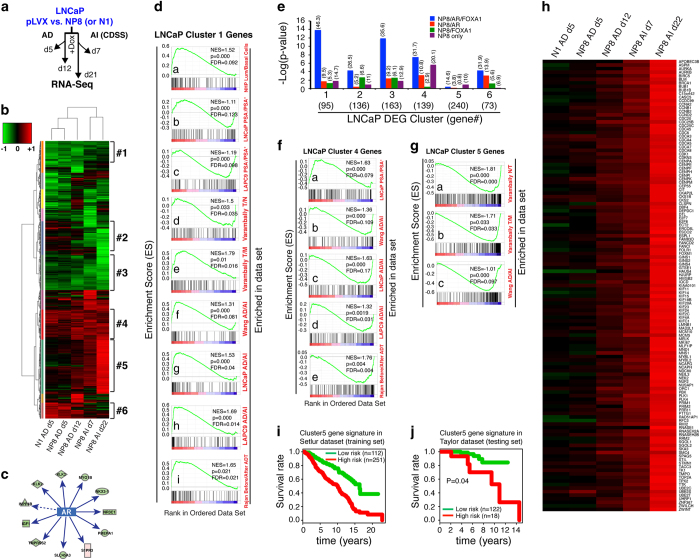
NANOG induces distinct gene expression changes correlated with castration resistance and patient survival. (a) Schematic showing RNA-Seq analysis of LNCaP cells overexpressing NANOG in either androgen-dependent (AD) or in androgen-independent (AI) conditions for the indicated time. (b) Unsupervised hierarchical clustering and heatmap presentation of all DEGs from the indicated groups (up/down >1.5× and P<0.05 relative to the pLVX control) in at least one group. Shown on the right are six clusters of genes that showed distinct patterns (Supplementary Figure S5). (c) IPA Upstream Regulator analysis implicated AR as a key NANOG target gene repressed under AD d5 (activation Z-score=−2.9), manifested by the downregulation of multiple AR target genes. (d) GSEA of cluster 1 genes in multiple data sets link them as AR-regulated pro-differentiation genes. (e) Integrative analysis of NP8 genomic occupancy (ChIP-Seq) and NANOG-induced DEG clusters. The analysis was performed by Fisher’s exact test to determine the enrichment of DEGs co-occupied by NP8 with AR and/or FOXA1 within a ±50 kb window of each peak. (f, g) GSEA of cluster 4 (f) and cluster 5 (g) genes in the data sets indicated implicate their involvement in castration resistance. (h) Heatmap presentation of the 127 genes in cluster 5 involved in DNA replication, cell cycle regulation and cytokinesis. (i, j) Survival analysis links cluster 5 genes to poor patient survival. A 58-gene signature from cluster 5 genes was used to stratify PCa patient survival in the Setlur data set (Supplementary Method), in which patients with higher expression of the signature had significantly shorter overall survival (that is, high risk of dying) than those with lower expression of the signature (i). The same signature also predicts for poor patient survival in a testing data set (j). In cluster 5, higher expression corresponds to higher risk.